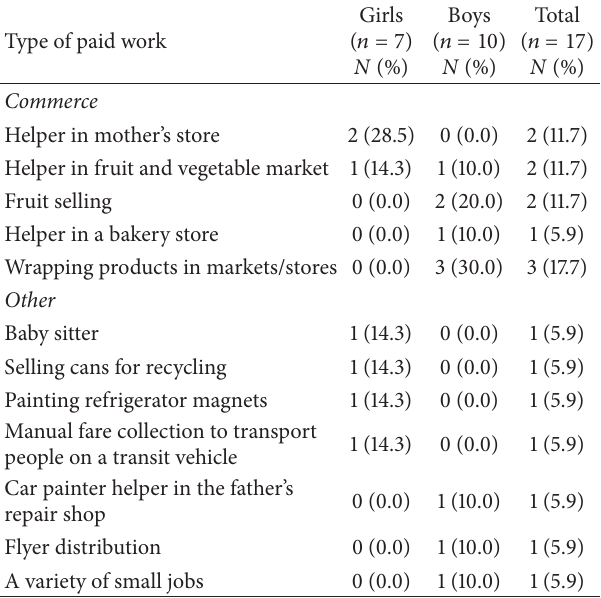
Table 1: Type of paid work activities among boys and girls aged 9–13 years that ever worked for pay ( 𝑛 = 17 ) in Embu, S˜ao Paulo,